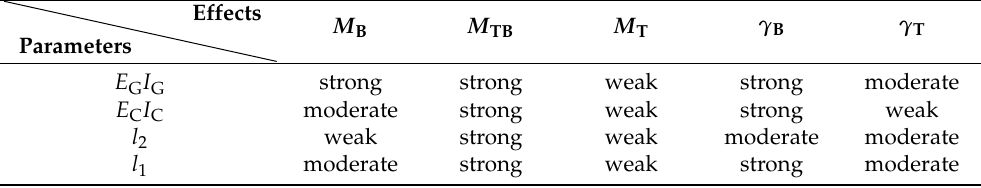
Table 4. Parameter